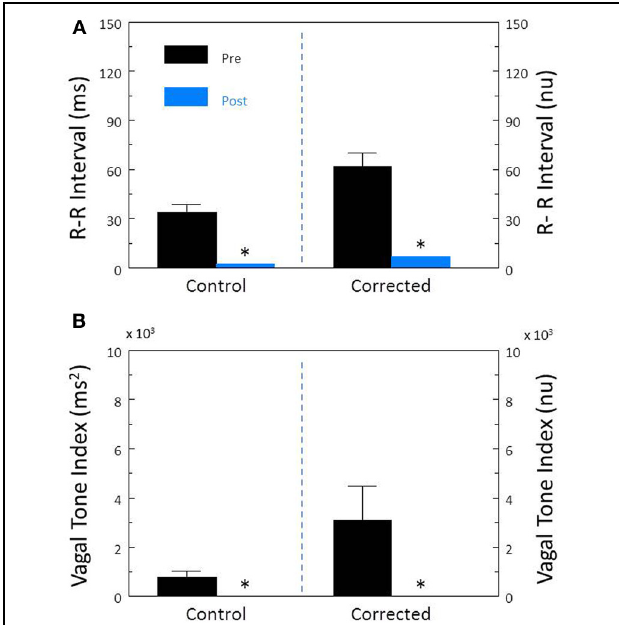
FIGURE 9 | The effect of bilateral cervical vagotomy on heart rate variability. The effect of surgical disruption of the vagus nerves ( n = 9) on total heart rate variability (standard deviation of R-R interval, RRSD) without and with correction (RRSD/mean RRsec) are displayed in (A) . The effects of this interval on the high frequency variability (cardiac vagal tone index, 0.24–1.04 Hz) without and with correction [cardiac vagal tone/(mean RRsec) 2 ] are shown in (B) . Note that despite correction for large increases in heart rate, the vagotomy still provoked large reductions in both RRSD and the cardiac vagal tone index. These changes are very similar to those noted after treatment with the cholinergic receptor antagonist atropine. Thus, the vagotomy data further indicate that cardiac parasympathetic activity is responsible for a large portion of the heart rate variability independent of changes in HR ∗ P < 0 . 01 pre (black bars) vs. post (blue bars); pre = last 30s before vagotomy, post = 30s interval recorded 5min after this treatment. nu, normalized units following HR